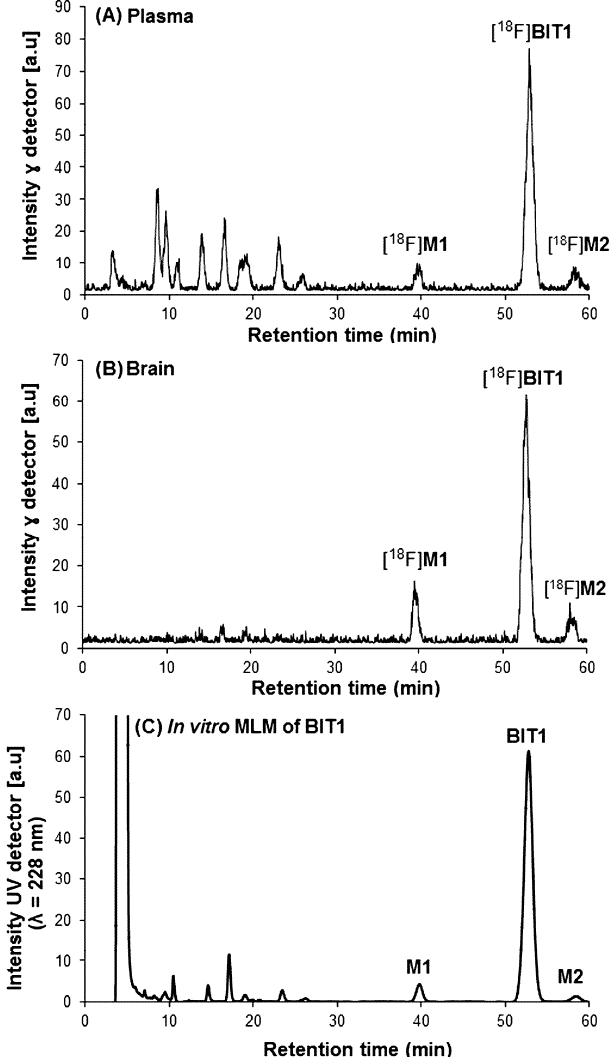
Figure 5. Representative analytical HPLC chromatogram: ( A ) plasma and ( B ) brain samples at 30 min p.i of [ 18 F] BIT1 in a CD-1 mouse; ( C ) sample from incubation of BIT1 with mouse liver microsomes (MLM) in the presence of NADPH for 90 min at 37 ◦ C (UV detection: 228 nm; axis of retention time was adjusted). Conditions: isocratic system, column: Reprosil-Pur C18-AQ, 250 × 4.6 mm; eluent: 42% MeCN in 20 mM NH 4 OAc aq. , flow: 1.0 mL/min.